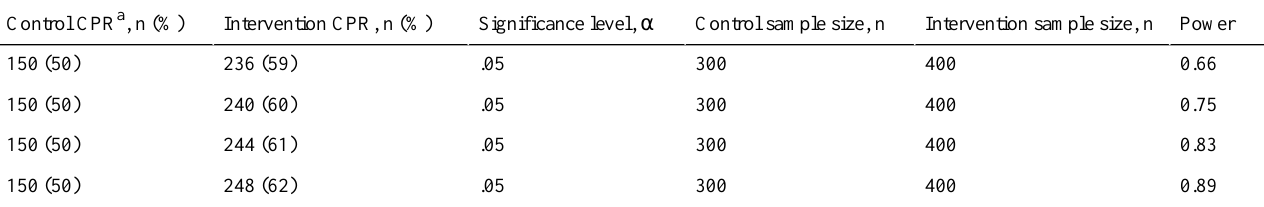
Table 4. Power calculations for contraceptive prevalence rate, partner invitation